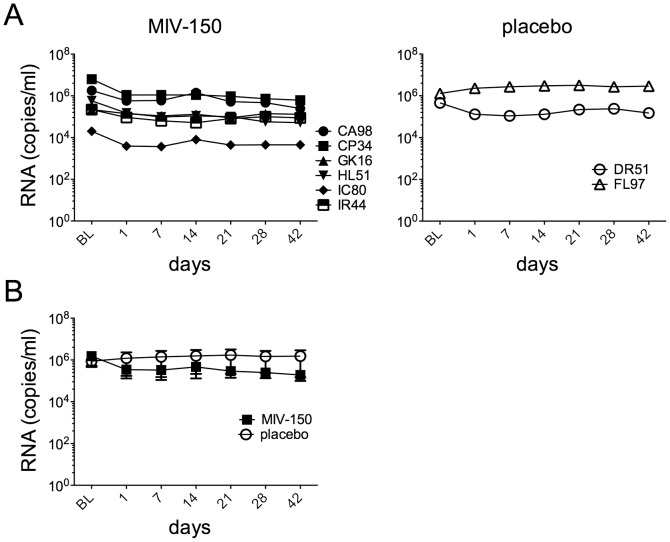
MIV-150 IVRs worn for 56 days have limited impact on plasma viremia.Plasma viral loads for individual animals are shown in A and mean viral loads (±SEM) are shown for both treatment groups in B.